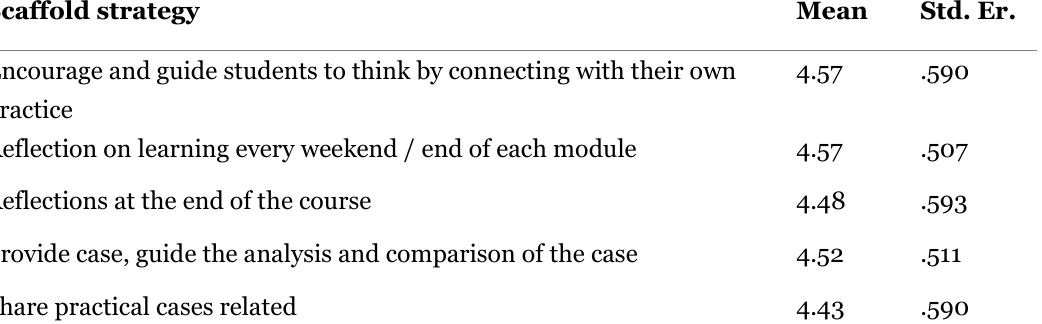
Most Effective Strategies for Cognitive Presence